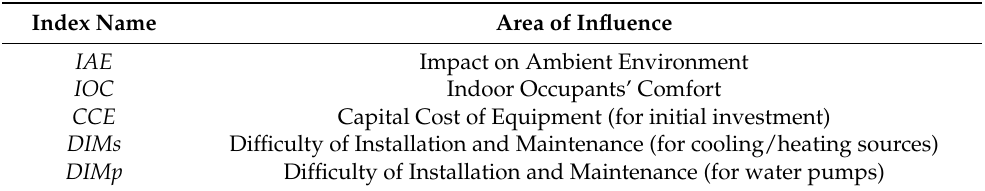
Table 4. Settings of the non-computable